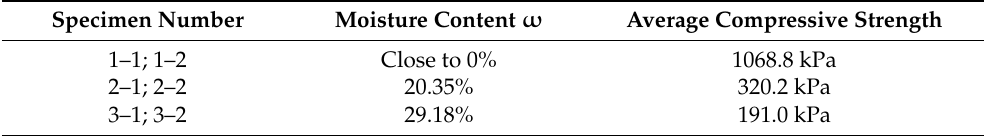
Table 1. Results of the uniaxial compression test.